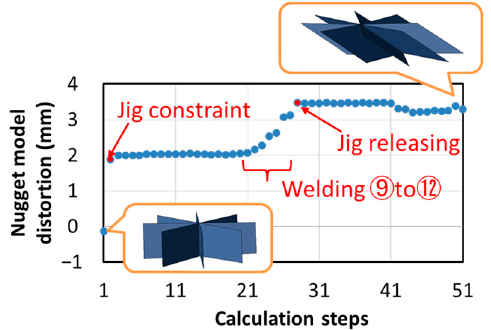
Figure 19. Time history of nugget model distortion at welding point 23.